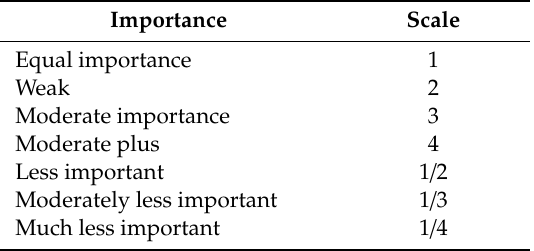
Table 2. Verbal and numerical expression of the relative importance of a pair of